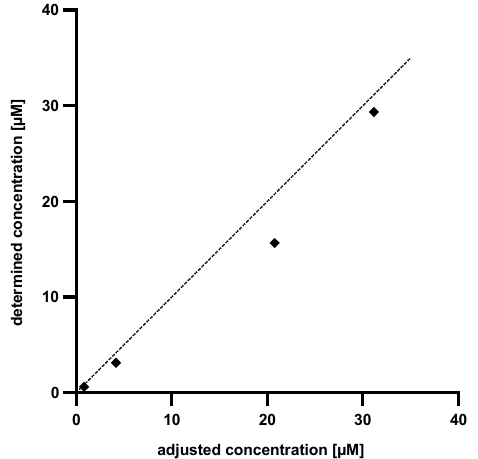
Figure 6. Plot of the determined concentration of Pep19 ‐ 2.5 (4 × 13 C 9 , 15 N 1 phenylalanines) against the adjusted concentration of Pep19 ‐ 2.5 (4 × 13 C 9 , 15 N 1 phenylalanines). The dotted line shows the calculated concentration of Pep19 ‐ 2.5 ( 13 C 9 , 15 N 1 phenylalanine).